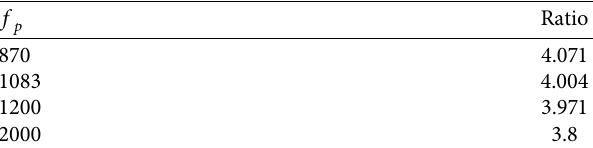
Table 2: Our evaluations for ratio. f